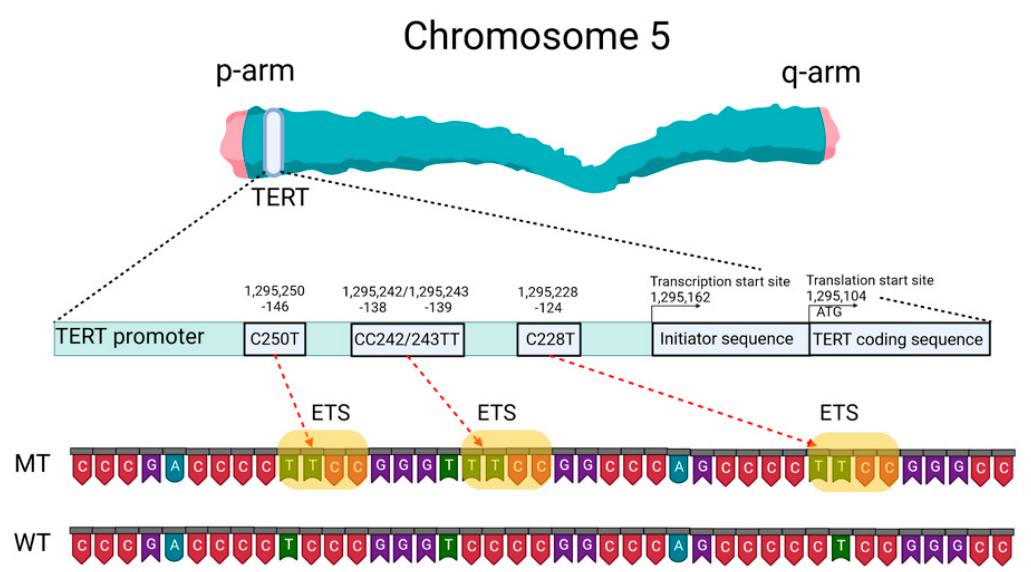
Figure 1. Schematic presentation of TERT gene at chromosome 5p, its promoter structure and two canonical mutations causing gliomagenesis. C >T mutation occurs at one of both positions of the TERTp ( − 124 and − 146 to ATG for C228T and C250T, respectively) in gliomas, which create de novo ETS binding motifs. CC242/243TT is a rare mutation and has not previously been seen in gliomas; it has been observed in other types of cancer. The figure was created with BioRender.com (19 March 2021).